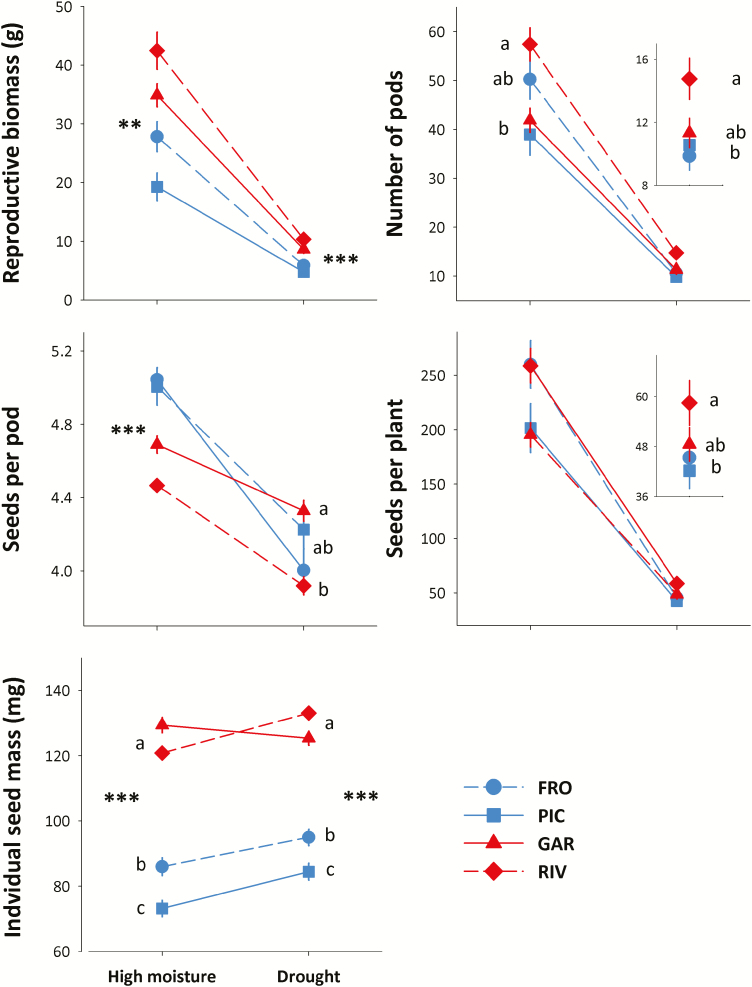
Population differences in reproductive traits in two contrasting water availability treatments. Each line shows the norm of reaction of each of two northern (blue) and two southern (red) populations for a given trait. Observed population means ± SE are shown for 21 families per population, with three replicates per family and treatment. Significant regional differences in each watering treatment are shown with asterisks (no asterisk: not significant differences; *P < 0.05; **P < 0.01; ***P < 0.001). Different letters indicate significant differences among populations in mean trait values within each watering treatment, according to Tukey post hoc tests. N = 504 plants for all traits. Population codes are those in Fig. 1.